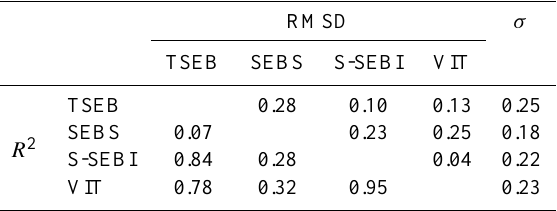
Table 5. Double-entry table of coefficient of determination R 2 (lower-left part) and RMSD (upper-right part) between the SEB models and their standard deviation σ on 10 March.